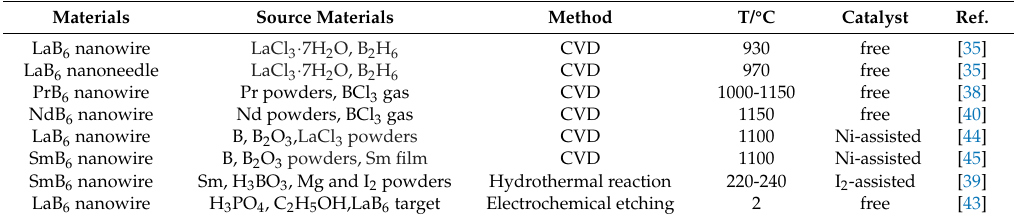
Table 1. The summary of the synthesis methods of different rare-earth boride nanostructures. CVD: chemical vapor deposition.